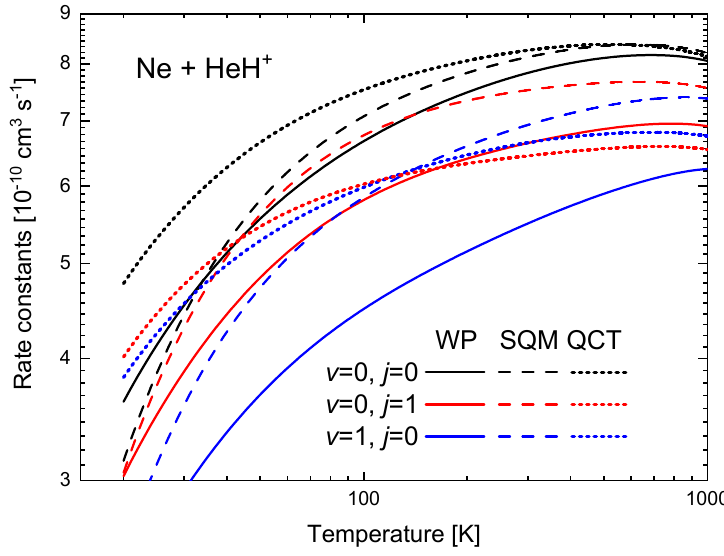
Figure 11. Rate constants (in 10 − 1 cm 3 s − 1 ) as a function of the temperature (in K) for the Ne + HeH + ( v , j ) → He + NeH + reaction for v = 0, j = 0 (black), v = 0, j = 1 (red) and v = 1, j = 0 (blue) obtained with the WP (solid lines), SQM (dashed lines) and QCT (dotted lines) calculations of Reference [63]. Logarithmic scales have been used in both